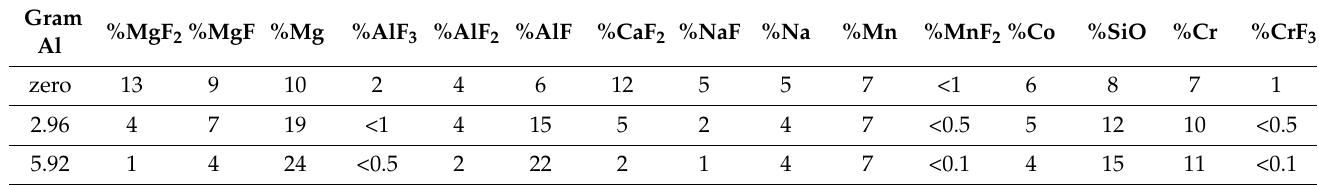
Table 10. MP9 expected metals loss to gas according to gas-slag-metal powder equilibrium at 2500 ◦